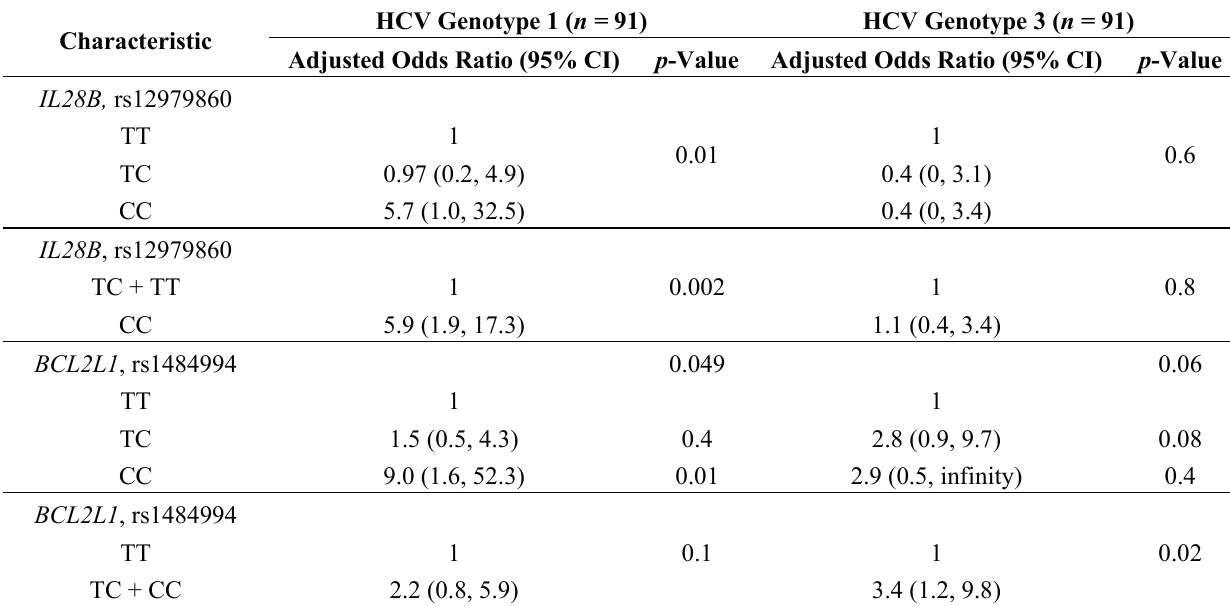
Table 3. Multivariate logistic regression of sustained virological response in 182 individuals with chronic hepatitis C virus